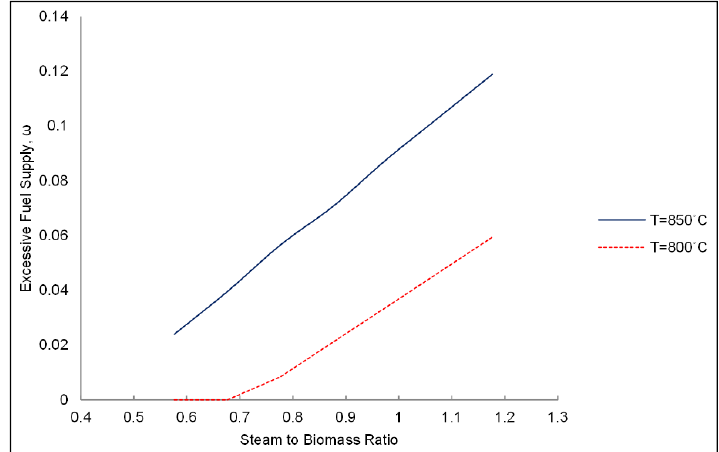
Figure 9. The excessive fuel requirement of the system versus S / B ratio.